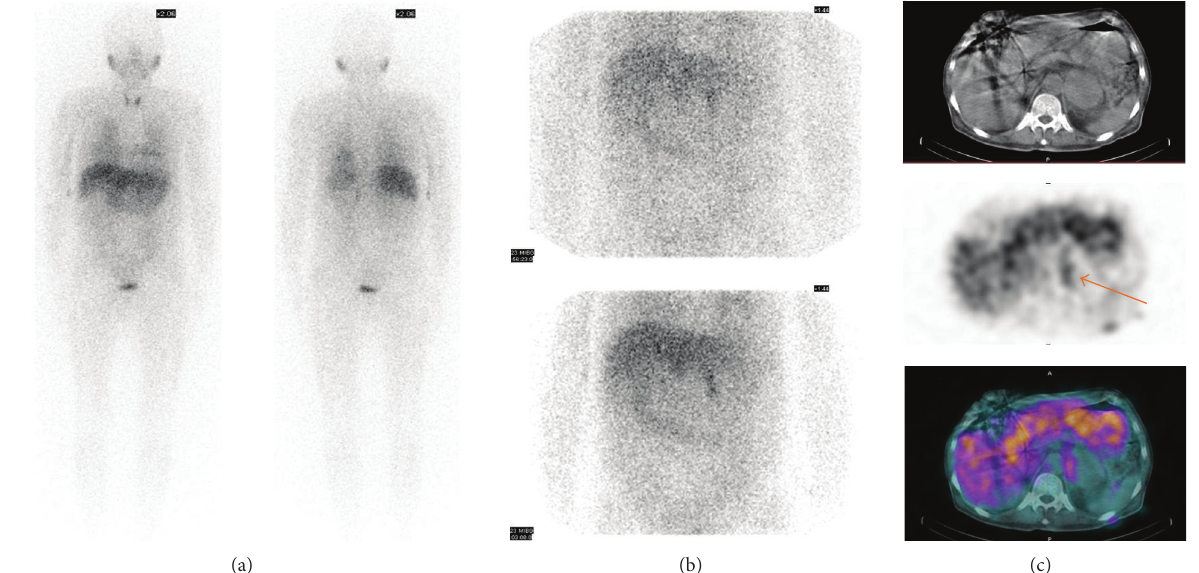
Figure 2: Early 123 I-MIBG scintigraphy showed no 123 I-MIBG uptake in suprarenal area (a). 24-hour delayed 123 I-MIBG scintigraphy, however, showed increased 123 I-MIBG uptake in left suprarenal area (b). On the image of 123 I-MIBG SPECT/CT, left adrenal gland tumor showed 123 I-MIBG uptake in the peripheral portion ((c), arrow).